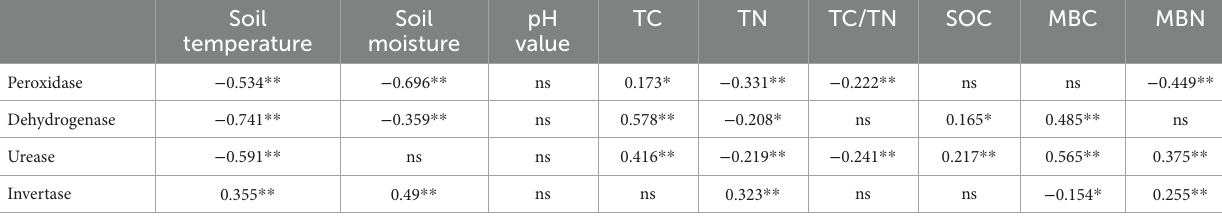
Soil Soil pH temperature moisture